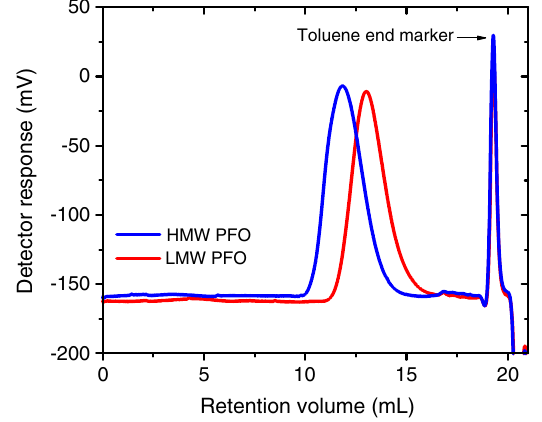
FIG. 13. Gel permeation chromatography (GPC) detection curves for both HMW (blue line) and LMW (red line) PFO solutions ( 1 . 2 mg mL − 1 in chloroform with 0.1 vol% toluene as the end marker). Monomodal molecular distributions for both PFO batches are evident. Note that M and M values for both w n materials, as listed in Table I, were extracted from the GPC curves based on conventional polystyrene-equivalent calibration.